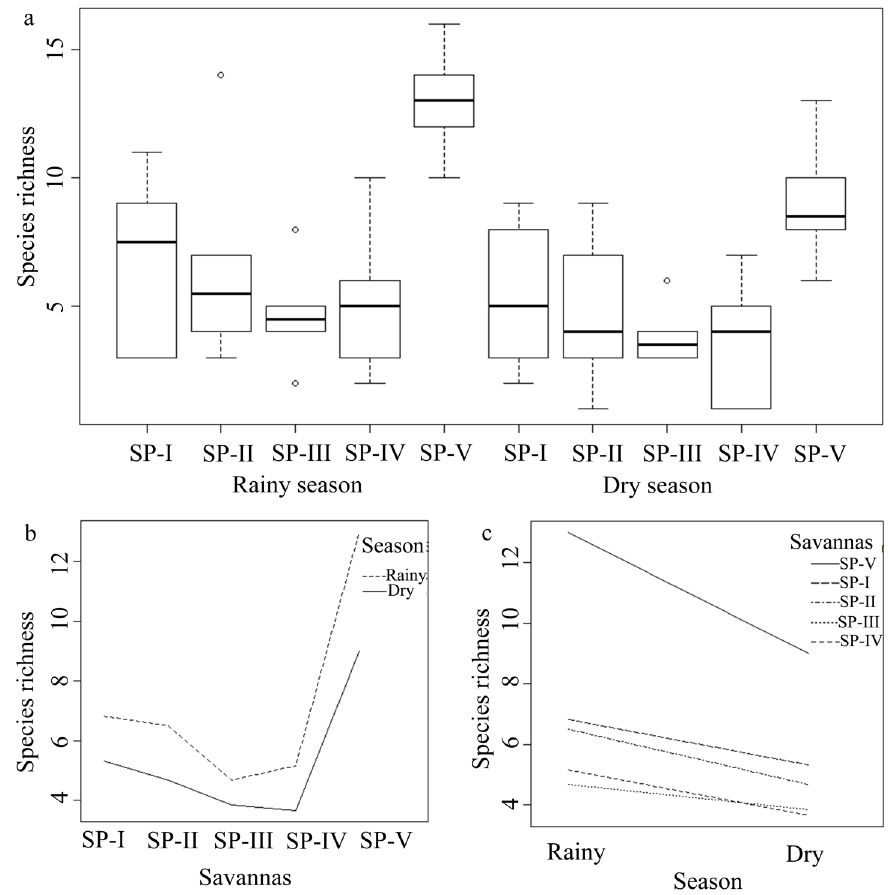
Figure 5. (a) Mean richness of bryophytes in the sampled savannas per season; (b) Interaction plot between sampled areas and seasons on mean richness of bryophytes; (c) Interaction plot between seasons and sampled areas on mean richness of